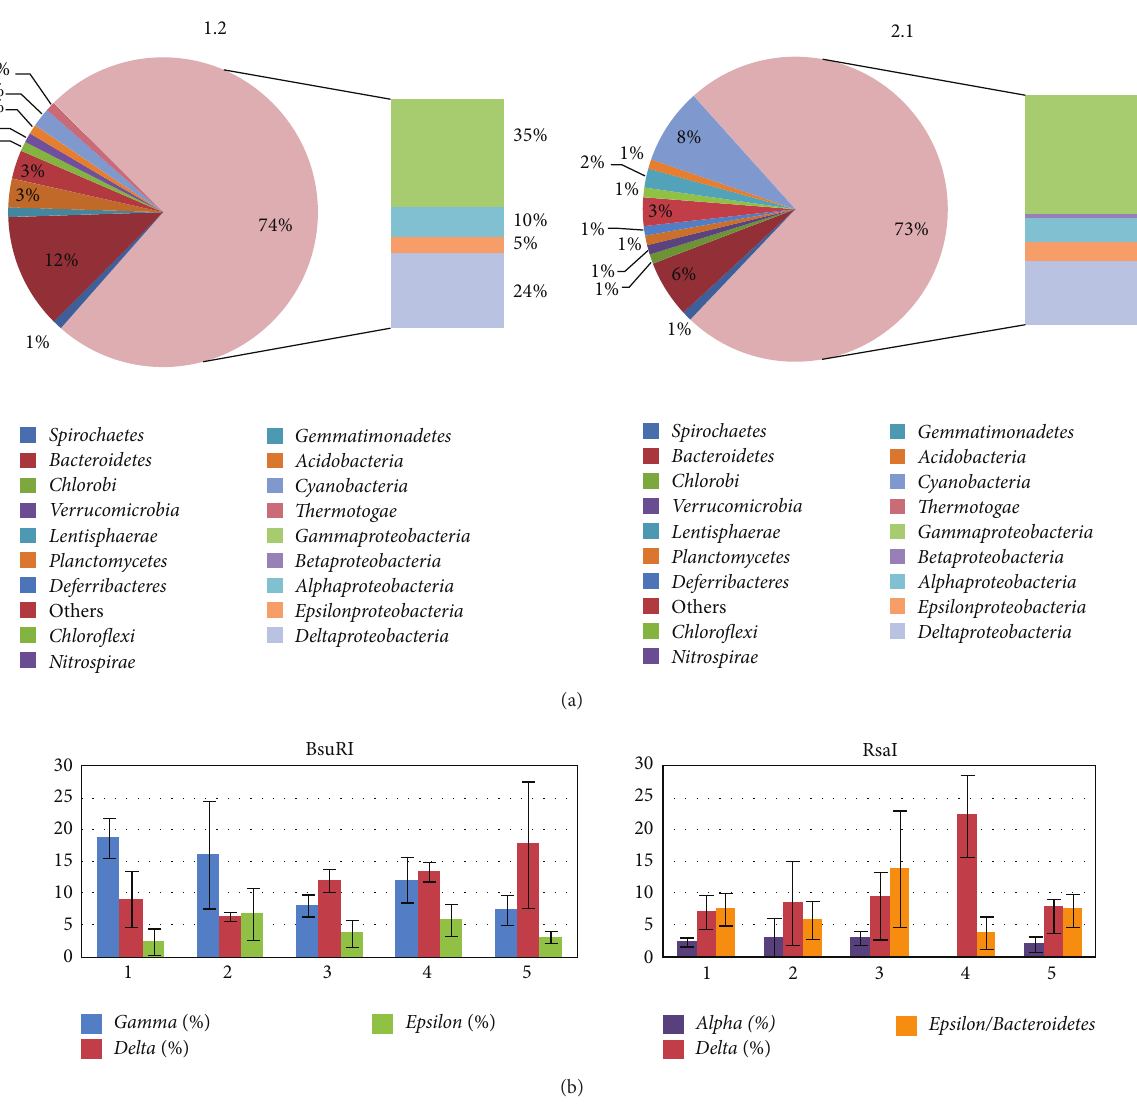
Figure 2: (a) Comparison among main bacteria phyla detected in the two clone libraries; the larger pink sectors represent Proteobacteria. (b) Coverage percentages of the main bacterial groups attributed through in silico digestion of the 15 T-RFLP electropherograms. Each of the five sites is represented by the means of three replicates; the black bars represent the standard deviations.